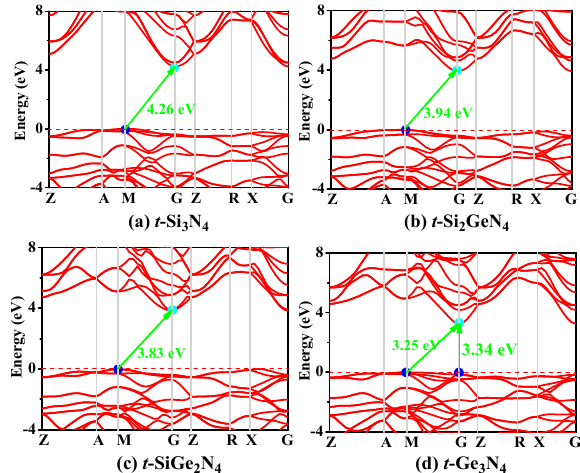
Figure 6. Electronic band structures of t -Si 3 N 4 ( a ); t -Si 2 GeN 4 ( b ); t -SiGe 2 N 4 ( c ); and t -Ge 3 N 4 ( d ) with the HSE06 hybrid functional.